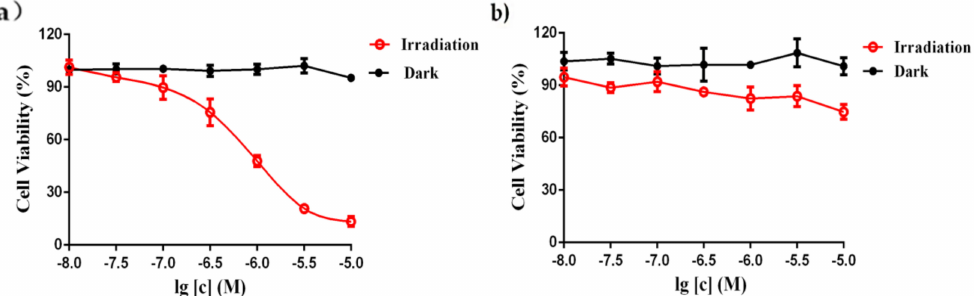
Figure 11. Cytotoxic effects of compound 7 on ( a ) HeLa and ( b ) HELF cells in the absence (black) and presence (red) of light ( λ = 670 nm, 20 mW · cm − 2 , 2.4 J · cm − 2 ). Data are expressed as the mean standard error of the means of three independent experiments, each performed in